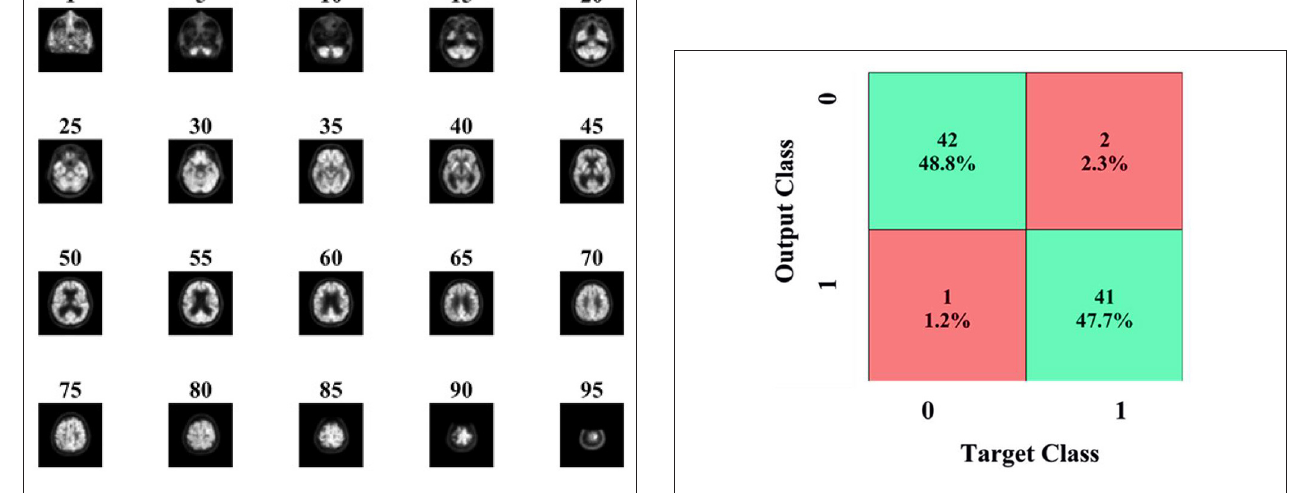
FIGURE 7 | Sample slices of AD